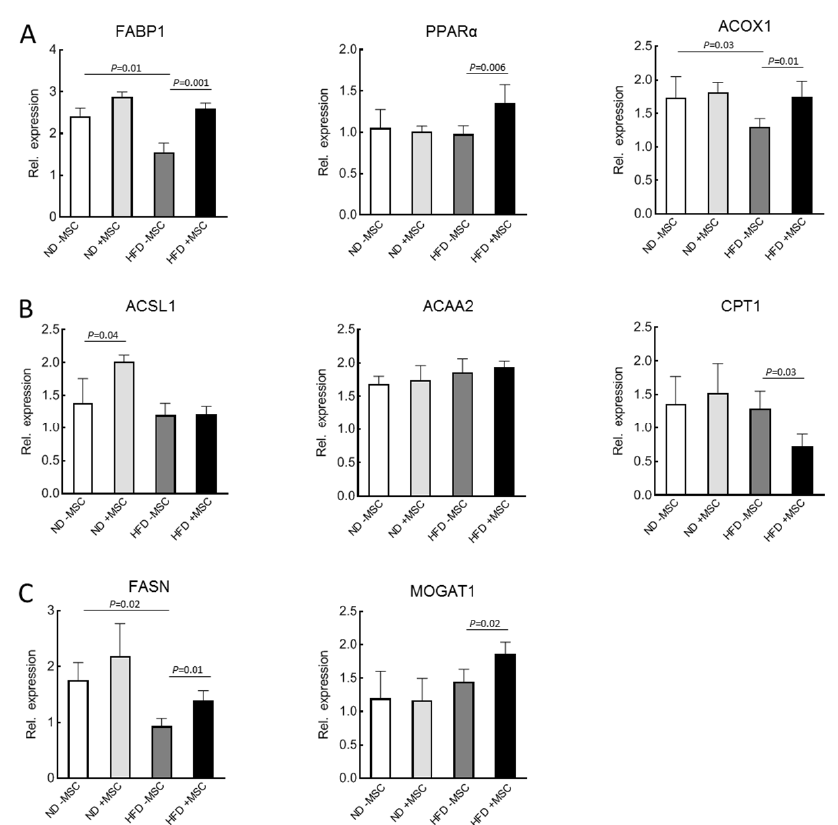
Figure 3. The mRNA expression of genes related to: ( A ) lipid utilization: FABP1, PPAR α , ACOX1; ( B ) β -oxidation: ACSL1, ACAA2 and CPT1; and ( C ) triglyceride synthesis: FASN and MOGAT1 in livers of high-fat-diet-fed mice (HFD) treated with human MSC (+MSC); quantification of mRNA abundance by sqRT-PCR followed by densitometry; expression was normalized to the abundance of β 2-microglobulin used as a housekeeping gene; values are means ± SD from 3 (ND − MSC), 4 (ND + MSC), 6 (HFD − MSC) and 8 (HFD + MSC) animals per group. Significant differences between the groups were validated by one-way ANOVA and the Newmann–Keuls test (SigmaStat; Jandel Scientific, San Rafael, CA,